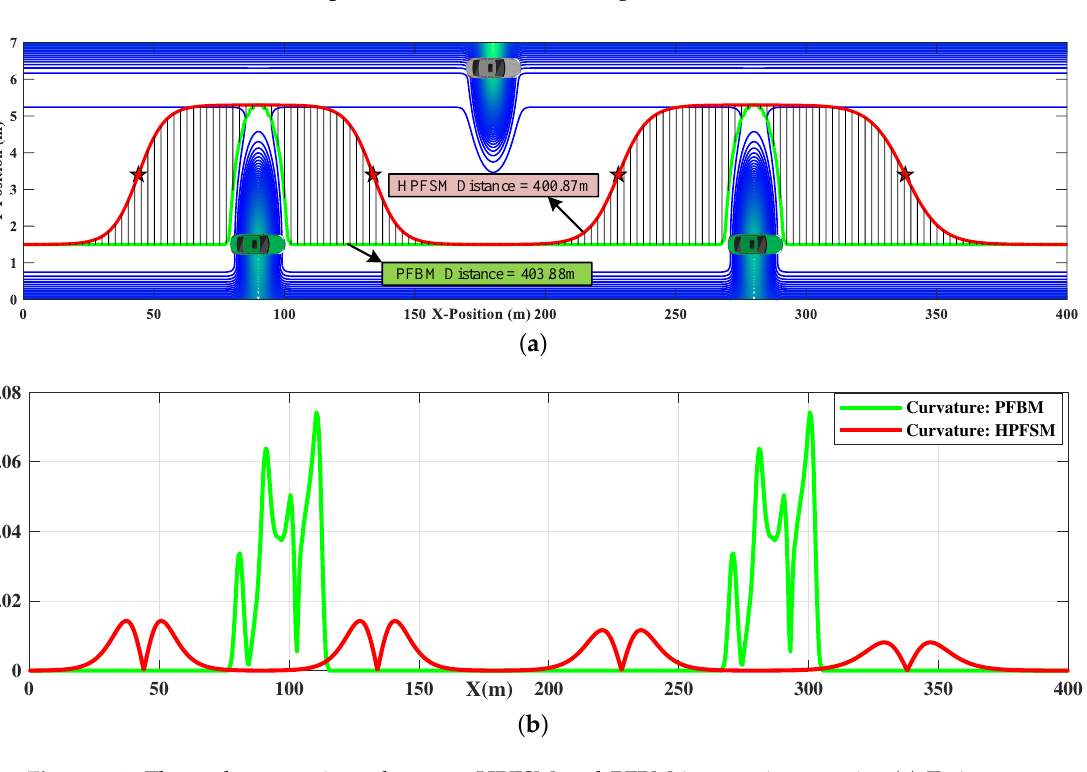
Figure 14. The path comparisons between HPFSM and PFBM in a static scenario: ( a ) Trajectory comparison: HPFSM vs PFBM; ( b ) Curvature comparison: HPFSM vs